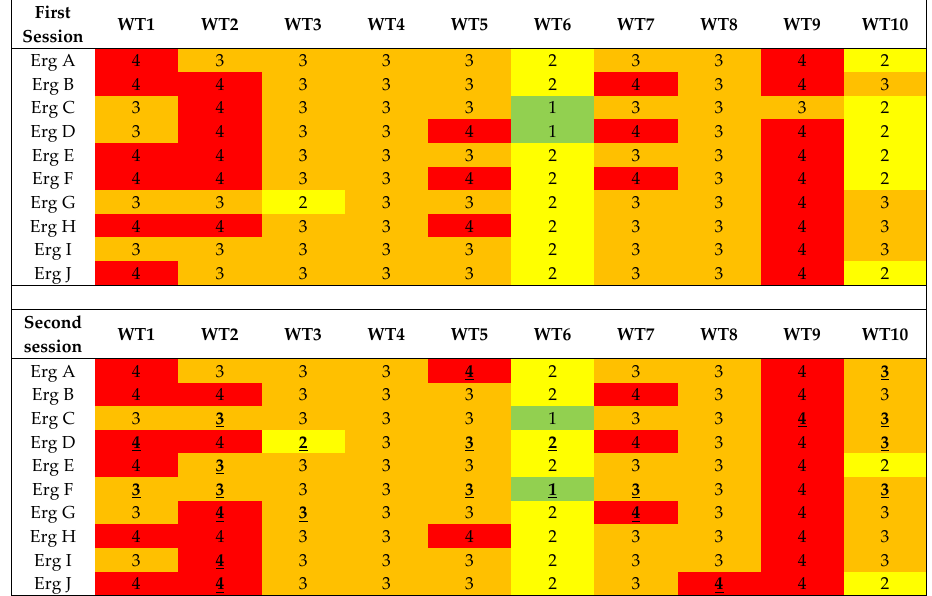
Figure 1. The results of the ten ergonomists (Erg A–J) that performed the risk level assessments using QEC (four levels) of the ten work tasks (WT) in both the first and second session. The colours refer to the different risk levels given in QEC. Green = Low, Yellow = Moderate, Orange = High, and Red = Very high. Bold and underlined numbers in the second session denote a difference from their first session